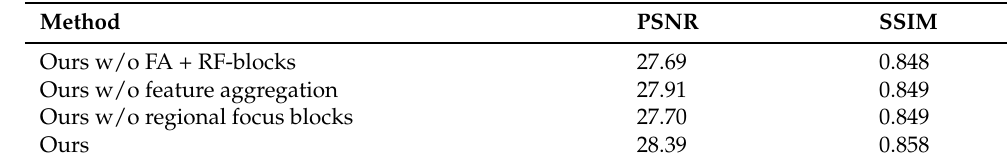
Table 1. Ablation experiments of our method on the Vid4 dataset, by removing different modules in the network and comparing the functions of different modules in the network